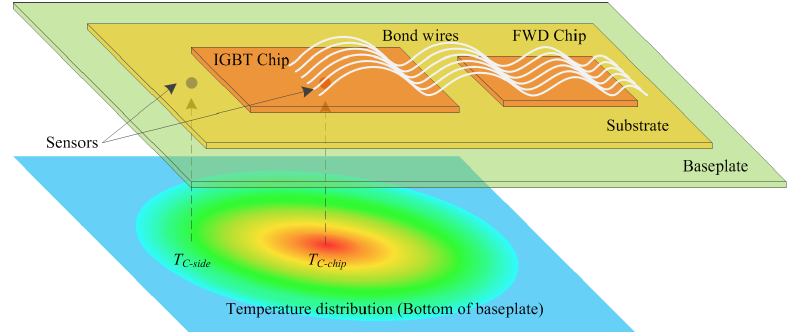
Figure 4. The placement of the sensors at the bottom surface of the device.